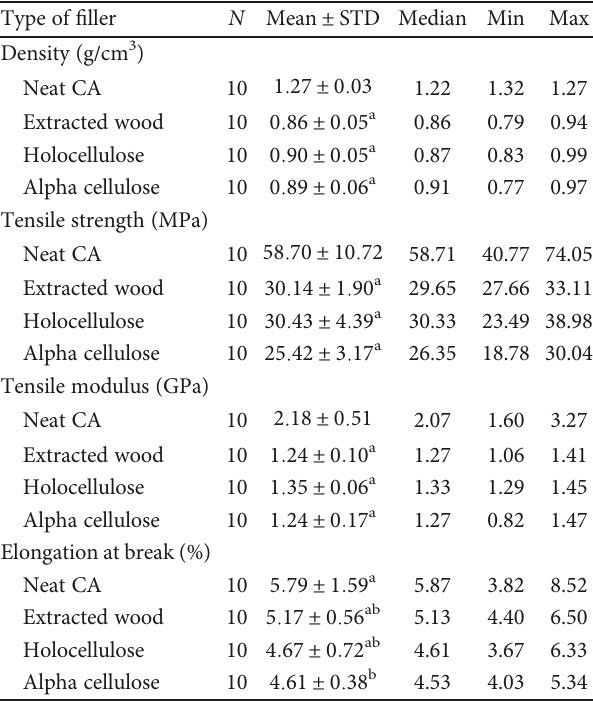
Table 6: Density and mechanical properties of biocomposites prepared from black